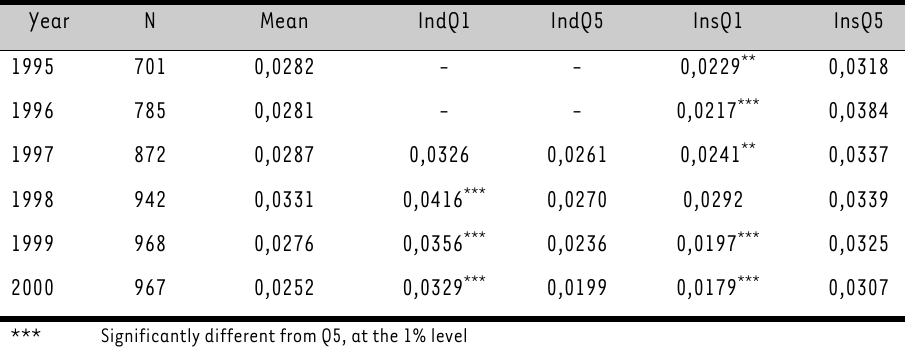
TABLE 4: Dividend payout in top and bottom quintiles by ownership